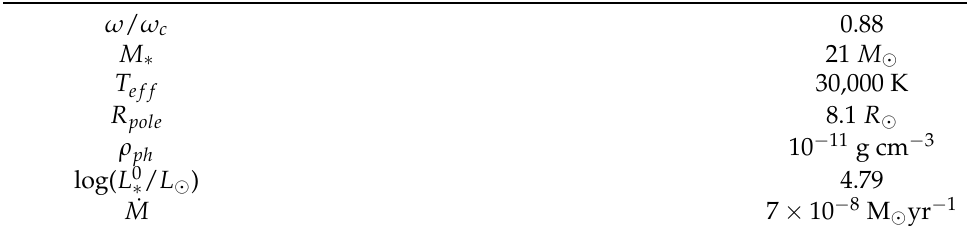
Table 1. Accepted parameters of LS